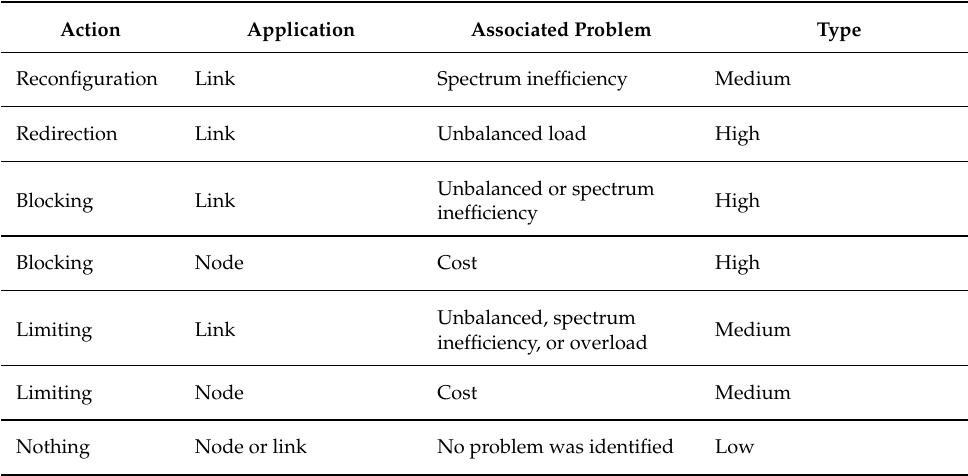
Table 4. Possible actions given by the Q -Learning